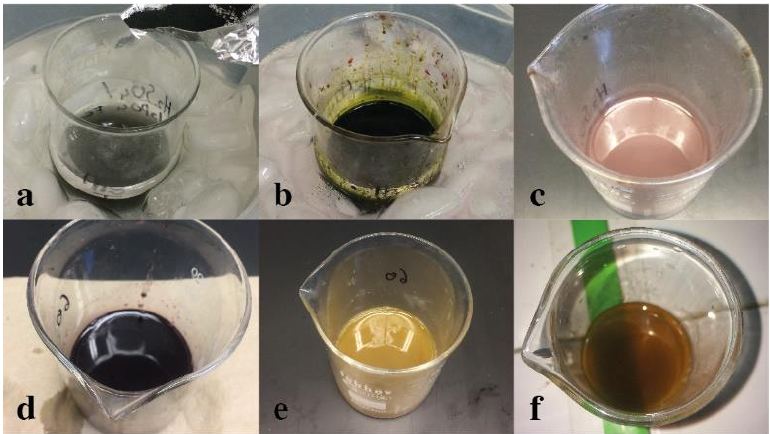
Figure 2. Color change of the mixture during the synthesis of GO. ( a ) Colorless of the suspension of graphite in acid; ( b ) green color due to the formation of Mn 2 O 7 when KMnO 4 was added to the mixture; ( c ) purple–brown mixture due to the formation of MnO 2 ; ( d ) dark purple color due to the residual KMnO 4 in presence of water; ( e ) H 2 O 2 produced a yellow color; ( f ) the GO reaction with water generated a dark brown color.